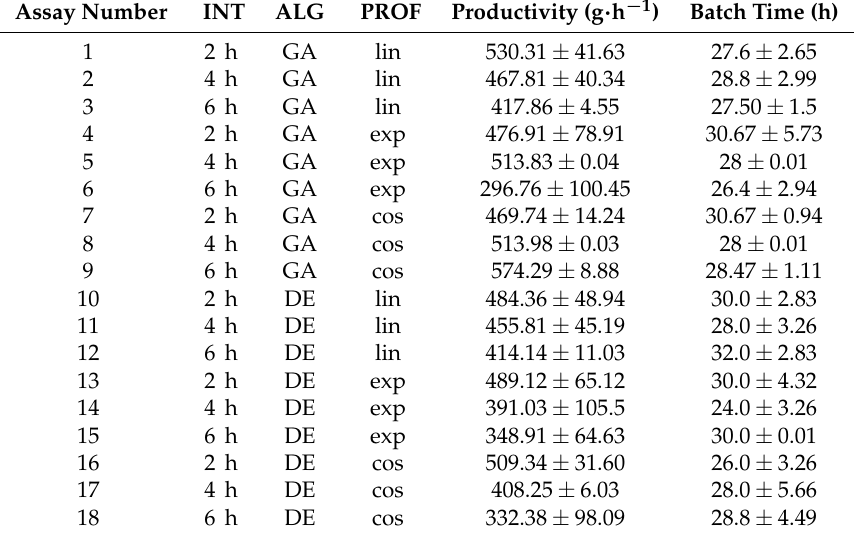
Table 6. Results obtained for the DRTO in terms of the time interval between the optimization cycles (INT), optimization algorithm employed (ALG) and canonical profile for the feed rate parametrization